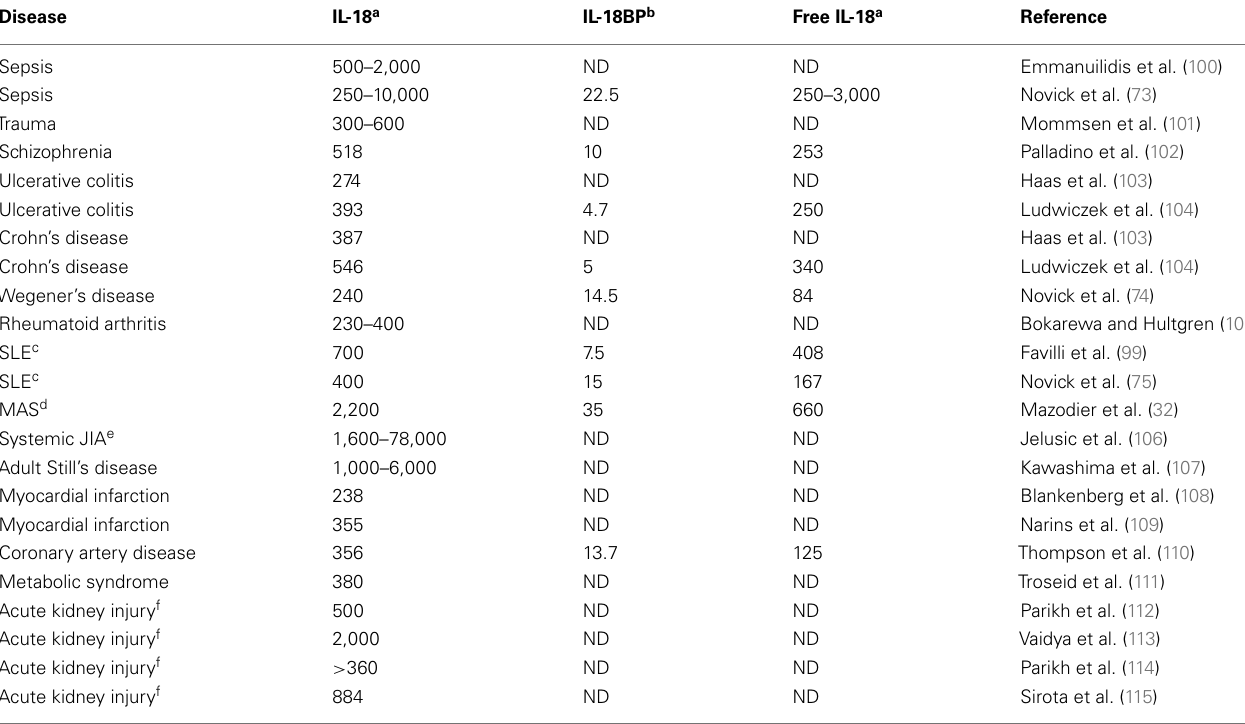
Table 1 | Levels of IL-18 and IL-18BP in human